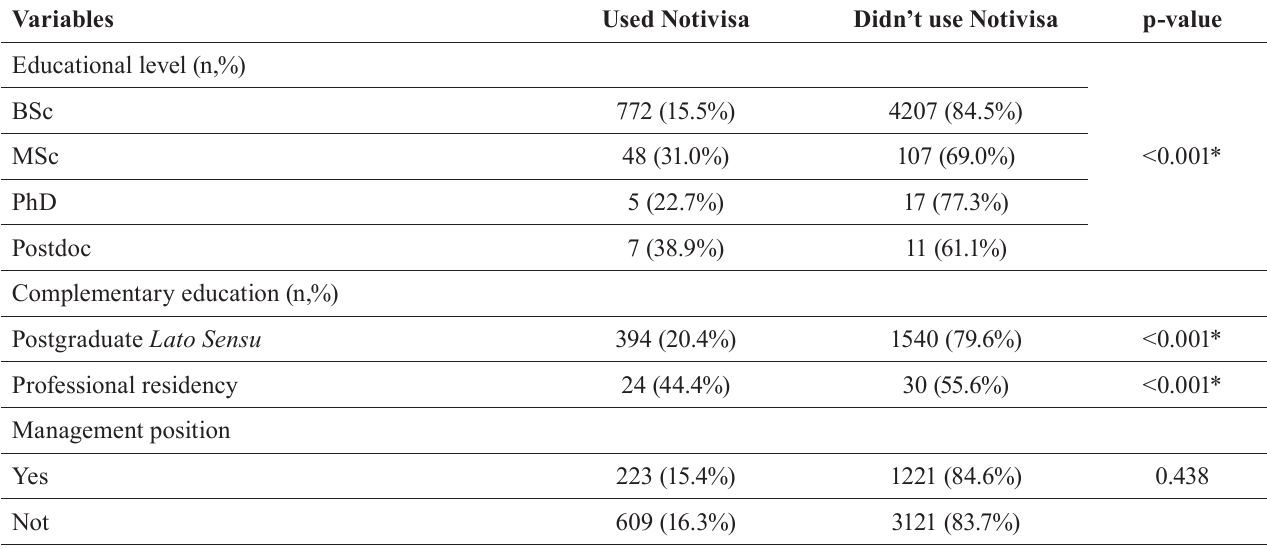
TABLE IV - Association between use of Notivisa and sociodemographic variables Variables Used Notivisa Didn’t use Notivisa